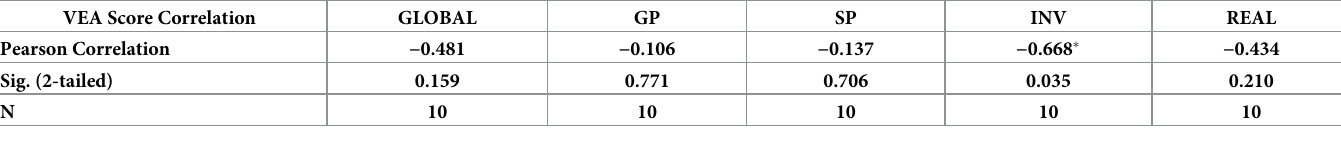
Table 4. Pearson correlation test (with